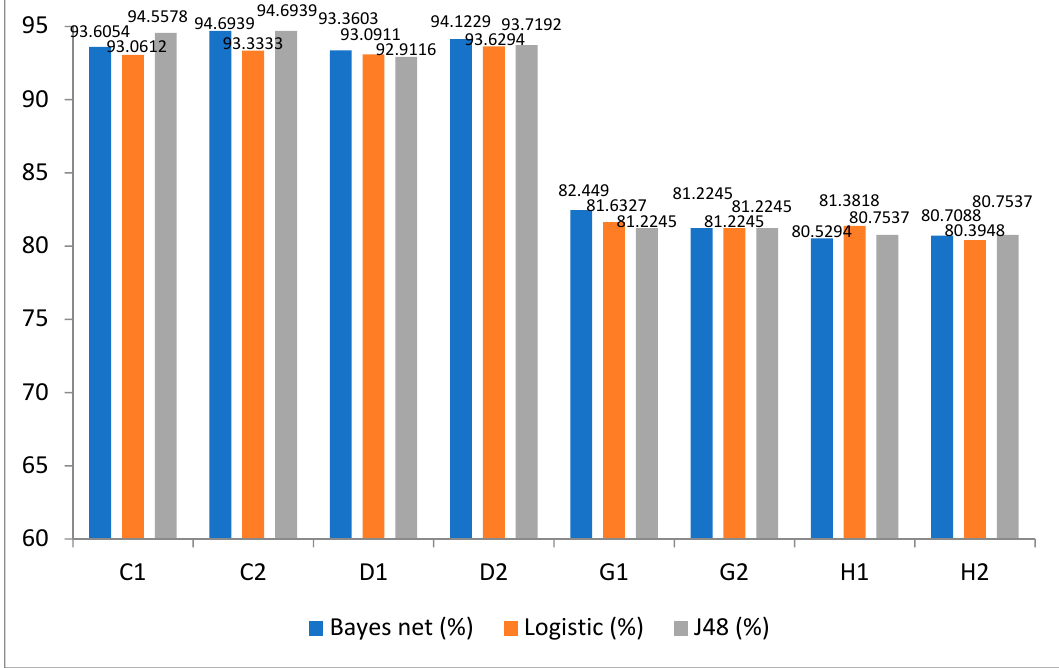
Figure 12. Bar graph with NSS as decision attribute.